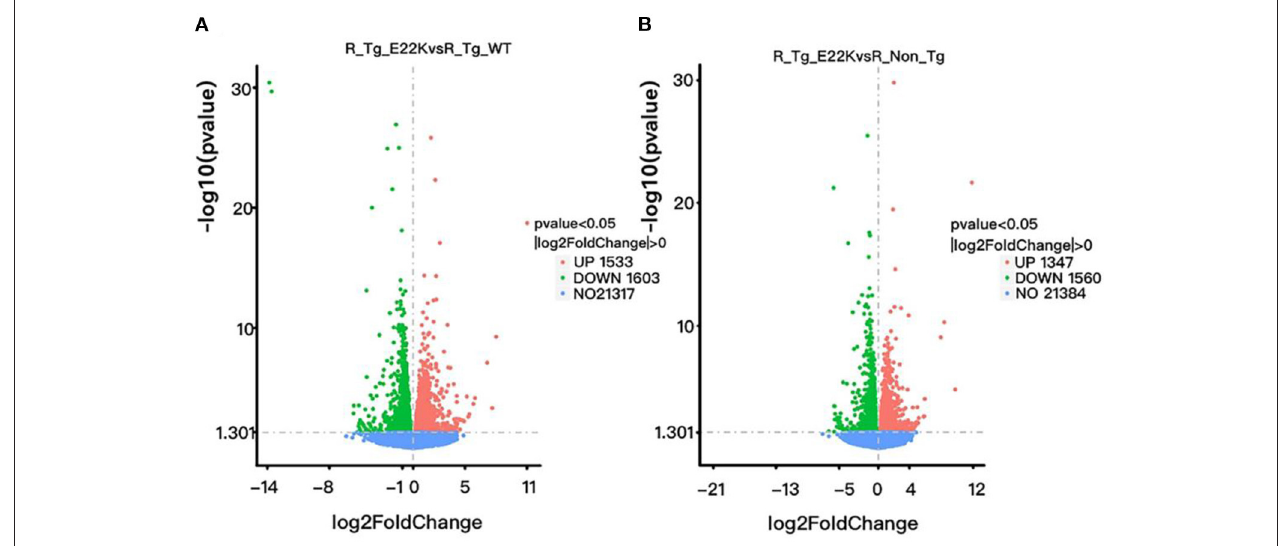
FIGURE 3 | E22K site mutation remarkably changes the gene expression profiles of cardiomyocytes in the left ventricle. Volcano map of DEGs (A,B) . There were 3,136 genes differently expressed between R-Tg-E22K and R-Tg-WT groups (A) , of which 1,533 and 1,603 genes were upregulated and downregulated, respectively, and 21,317 genes remained unchanged. There were 2,907 genes differently expressed between R-Tg-E22K and R-Non-Tg groups (B) , of which 1,347 and 1,560 genes were downregulated and upregulated, respectively, and 21,384 genes were not altered. R-Tg-WT, wild-type transgenic mice in the rest group; R-Tg-E22K, transgenic E22K mice in the rest group; R-Non-Tg, non-transgenic wild-type mice in the rest group.